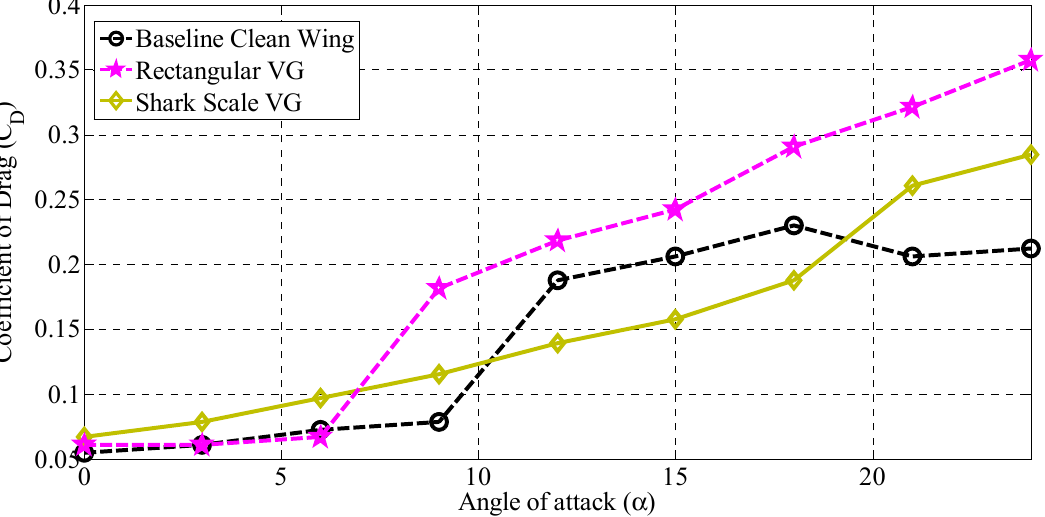
Figure 8. Coefficient of drag ( C D ) with the angle of attack ( α ) for baseline and modified model with SSVG.